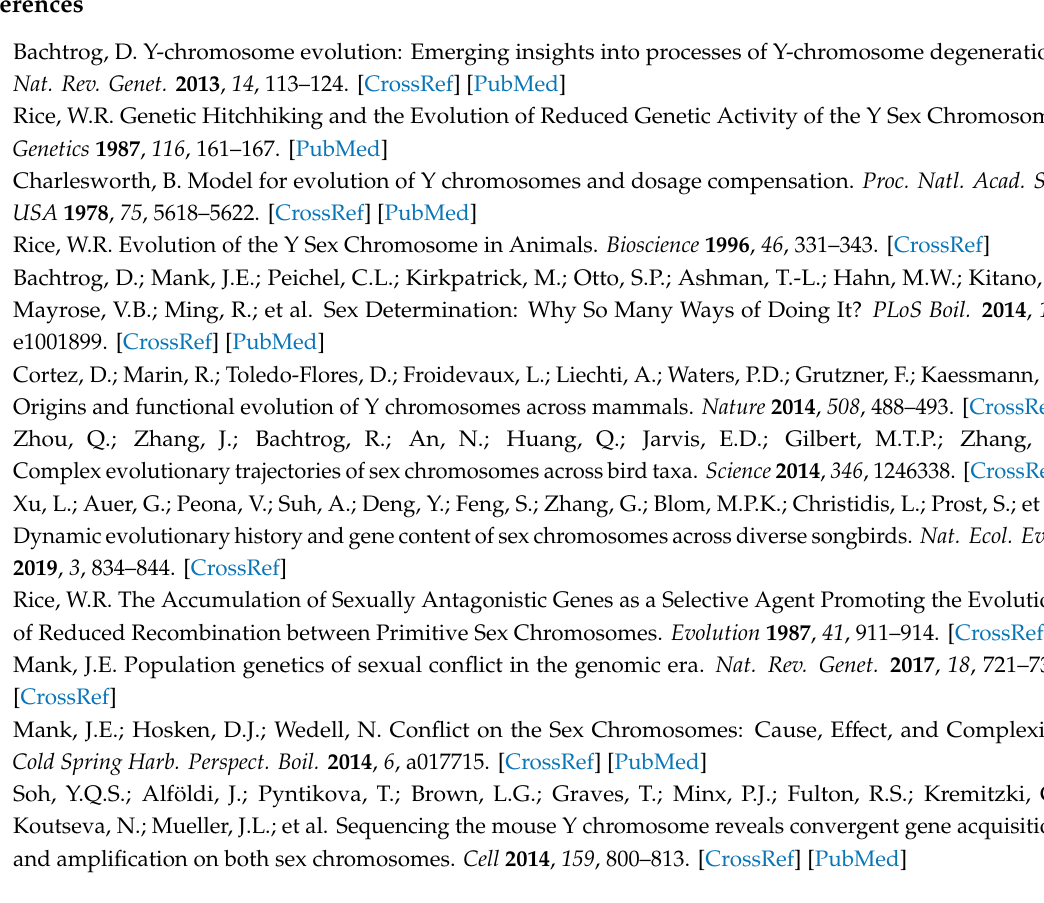
Figure S1: Sequencing coverage of female reads along the Z chromosome, Figure S2: Demarcation of evolutionary strata of the paleognath sex chromosomes, Figure S3: The retained genes on bird W chromosomes have high ancestral expression and dosage-sensitivity, Figure S4: The retained genes on bird W chromosomes do not have more ovary dominant genes, Figure S5: Estimation of Hint1w copy number in tinamous; Table S1: Accessions of NCBI genome assemblies and RNA-seq SRA, Table S2: Statistic test for overrepresentation of dosage-sensitive and high-expression